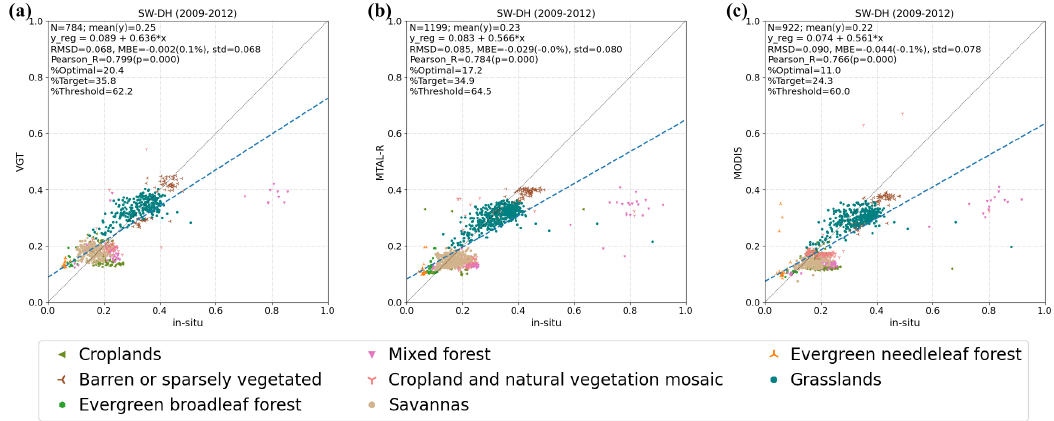
Figure A2. Accuracy assessment of ( a ) VGT, ( b ) MTAL-R and ( c ) MODIS surface albedo satellite products versus ground measurements coming from GBOV, AMMA and BSRN stations during the 1 January 2009–31 December 2012 period. All data are included. The continuous black line corresponds to the 1:1 line. The blue dashed line corresponds to the regression